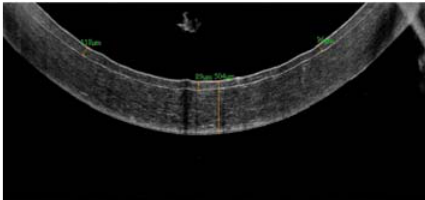
Figure 3: An AS-OCT image of precut donor cornea for Descemet’s stripping automated endothelial keratoplasty (DSAEK) taken for evaluation of thickness of graft donor tissue.